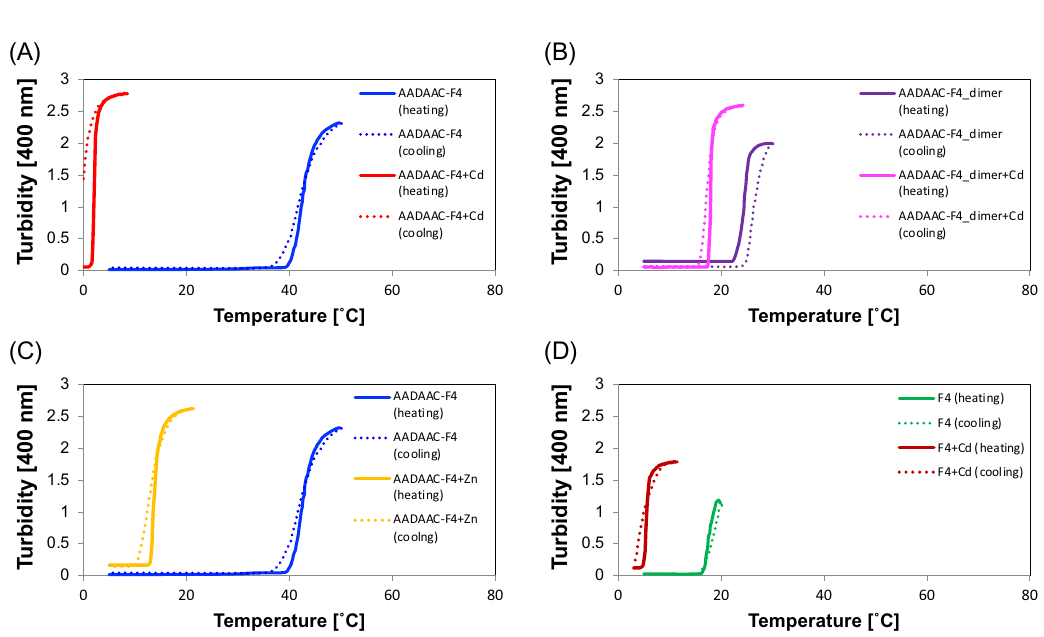
Figure 2. Turbidity profiles of AADAAC-F4, AADAAC-F4-dimer, and F4. Turbidity changes of the synthesized peptide in Tris–HCl buffer solution (50.0 mM Tris, 599 mM NaCl, pH 8.0) associated with heating (solid lines) and cooling (dashed lines). ( A ) AADAAC-F4, 4.26 mM (blue lines); and AADAAC-F4, 4.26 mM with 4.26 mM CdCl 2 (red lines). ( B ) AADAAC-F4-dimer, 2.13 mM (purple lines); and AADAAC-F4, 2.13 mM with 4.26 mM CdCl 2 (magenta lines). ( C ) AADAAC-F4, 4.26 mM (blue lines); and AADAAC-F4, 4.26 mM with 4.26 mM ZnCl 2 (yellow lines). ( D ) F4, 5.42 mM (green lines); and F4, 5.42 mM with 4.26 mM CdCl 2 (brown lines).